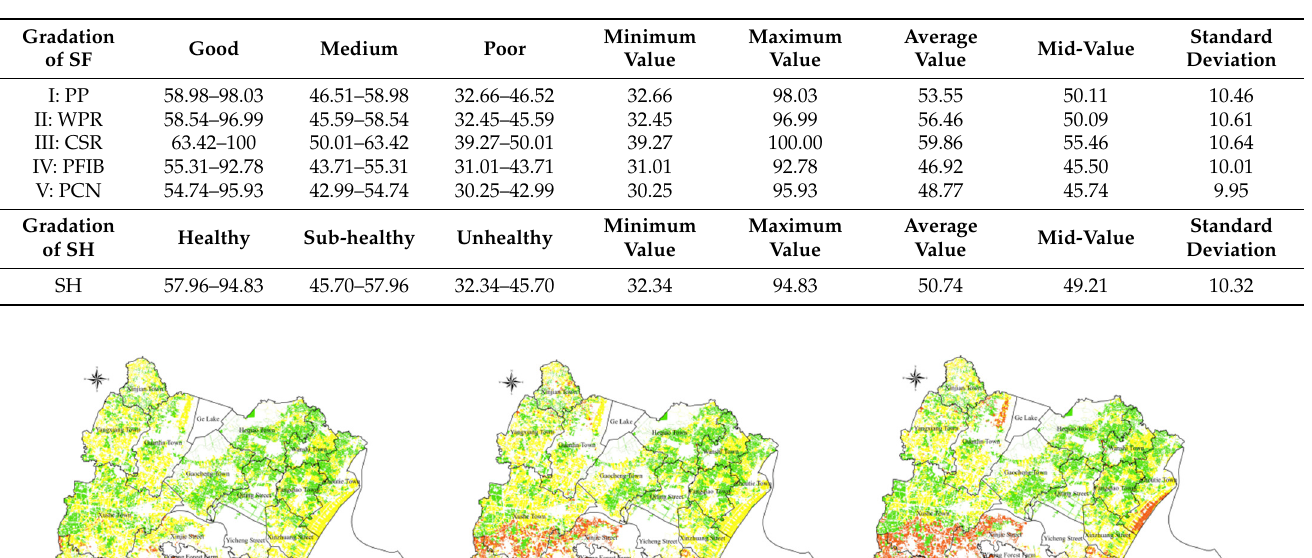
Table 4. Gradation of SF and SH in Yixing City.